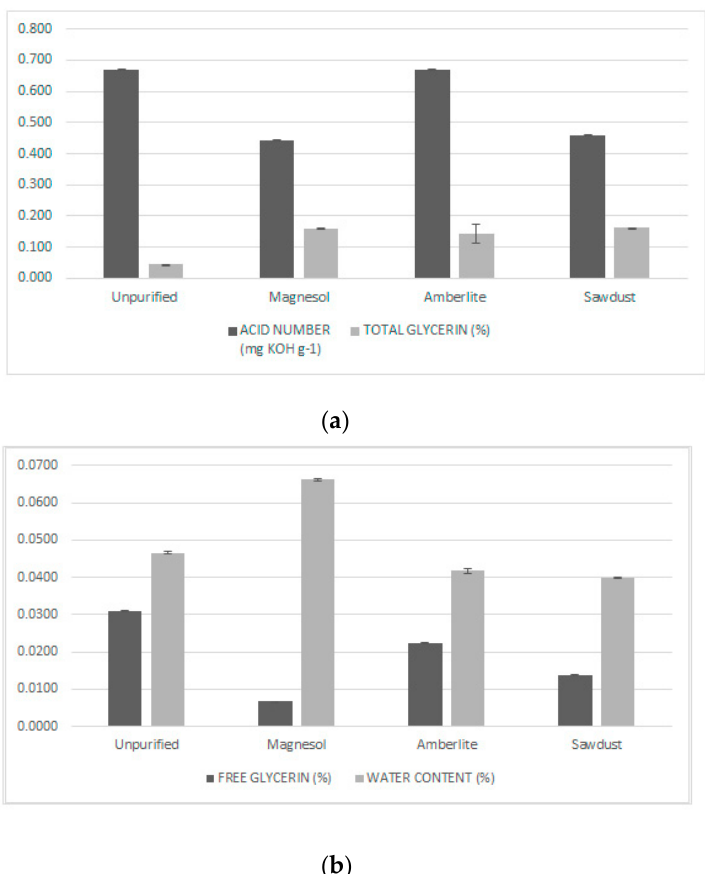
Figure 1. Comparison between sawdust and conventional purification methods of biodiesel from waste cooking oil (WCO): ( a ) acid number (mg KOH g − 1 ) and total glycerin (%), ( b ) free glycerin (%) and water content (%). Error bars are based on standard deviation of duplicate analysis.